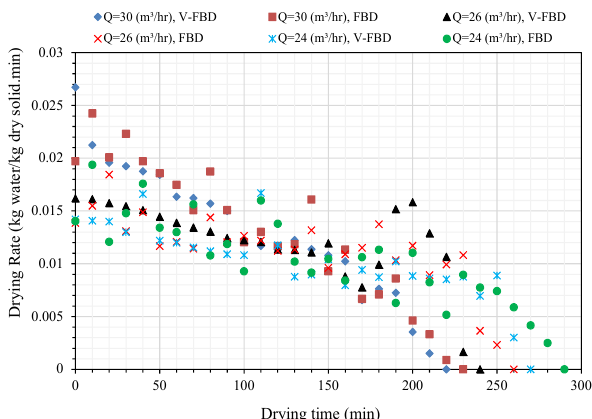
Fig. 12. Drying rate versus moisture content at different drying air flow rates with and without vibration (drying air temperature=50 o C, vibration intensity=7.5 Hz)